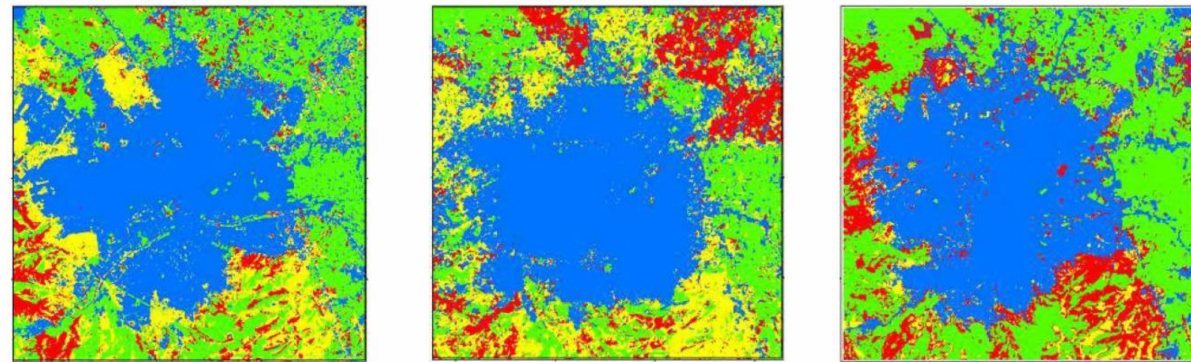
Figure 10. Land cover prediction maps for 2030 by CA-ANN using classification results of MLC ( left ), SAM ( middle ), and SVMs ( right ).